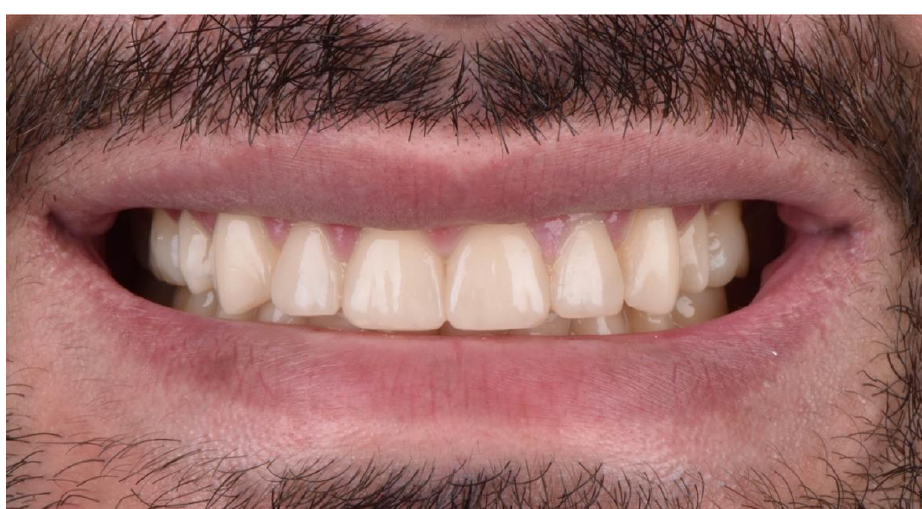
Figure 29. Final extraoral smile picture (left).